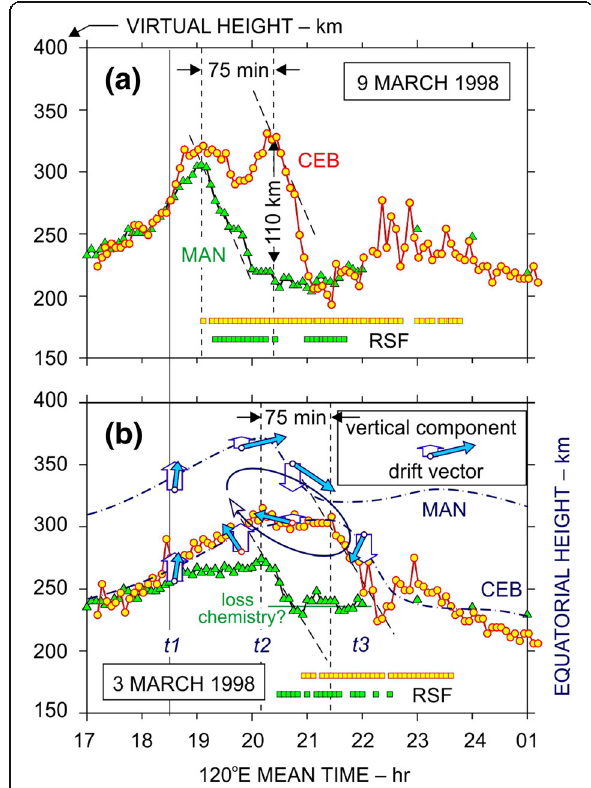
Fig. 6 a Plots of h ’ F (2) versus LT for MAN and CEB, from 9 March 1998. Times for RSF occurrence are shown by horizontal bars. b Similar h ’ F (2) curves from 3 March 1998, together with RSF occurrences. Also, superposed are plasma flow vectors (blue arrows) and their vertical components (fat white arrows), which are based on simple model results. Original figures, from Maruyama et al. (2002), have been reproduced, colored, and